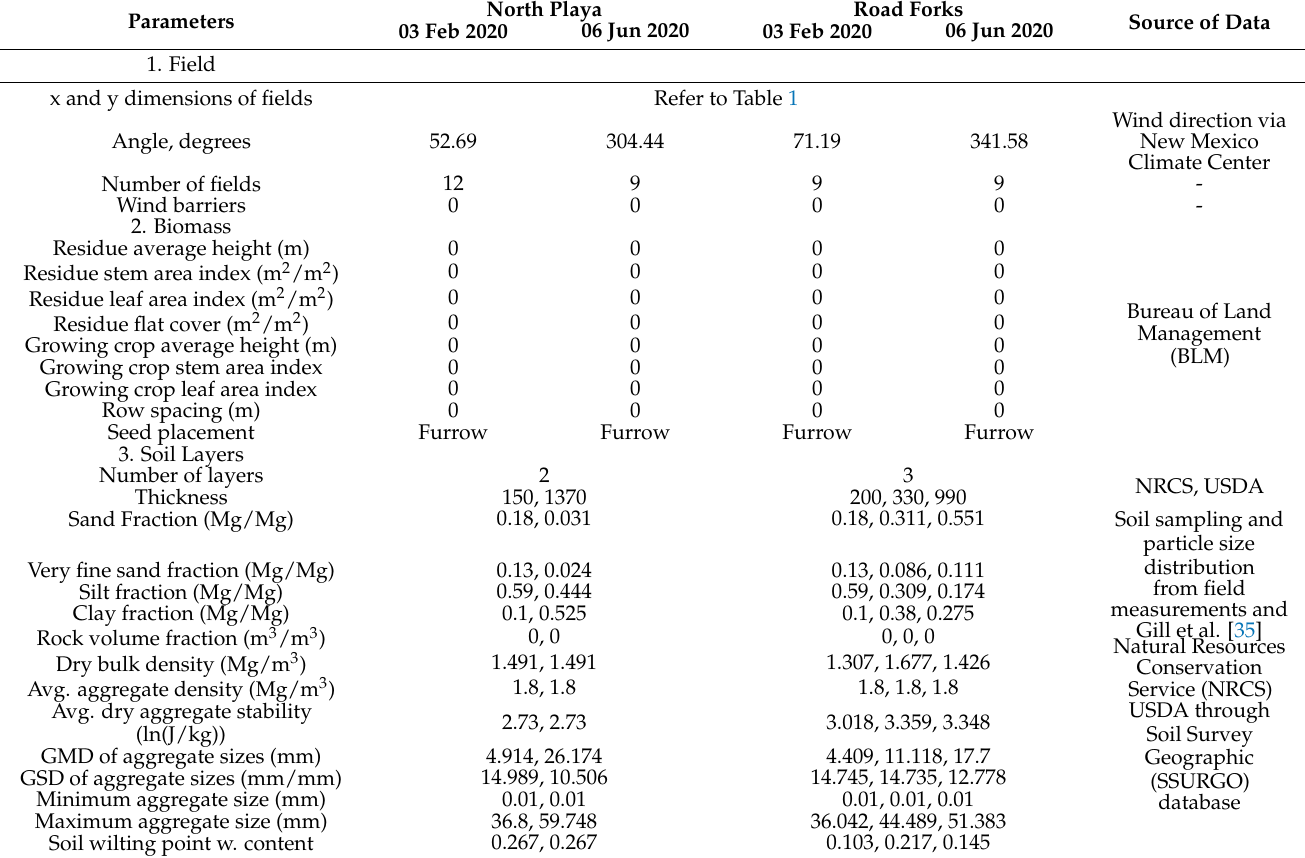
Table A1. Parameters required by the SWEEP model to simulate wind erosion for the two selected